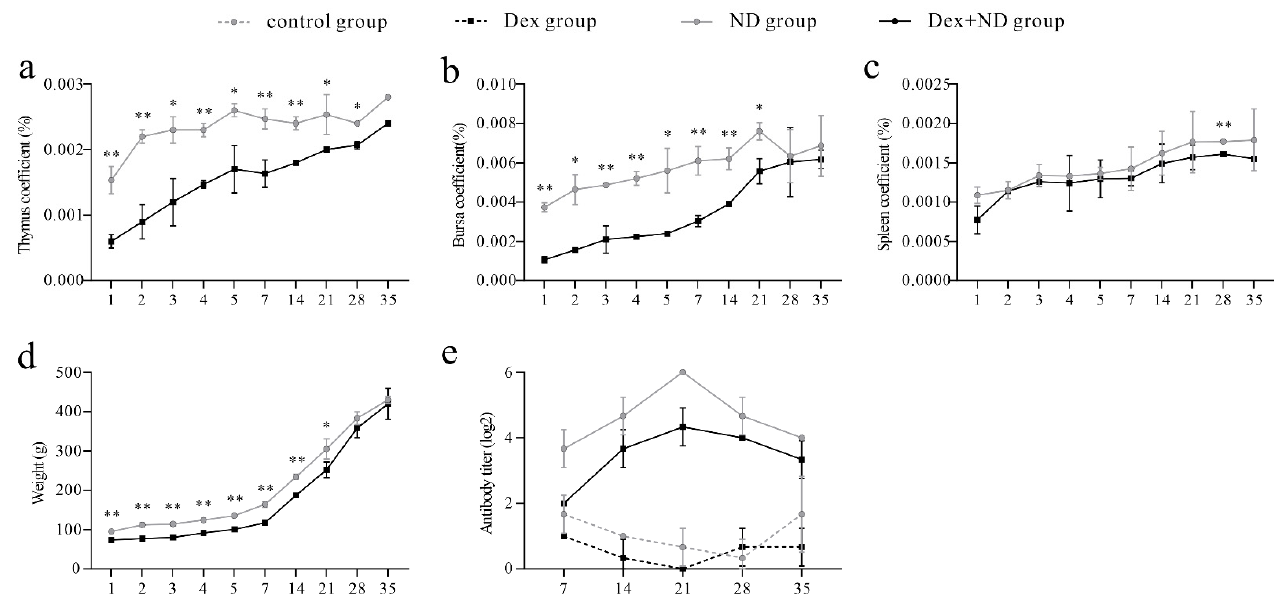
Figure 1. The identification results of immunosuppressed chicken model. ( a – d ) Comparison results of body weight and organ coefficient between ND group and Dex + ND group, respectively. * Significant difference between the two groups ( p < 0.05); ** very significant difference between the two groups ( p < 0.01). ( e ) Serum Newcastle disease virus (NDV) antibody titers in different treatment groups.